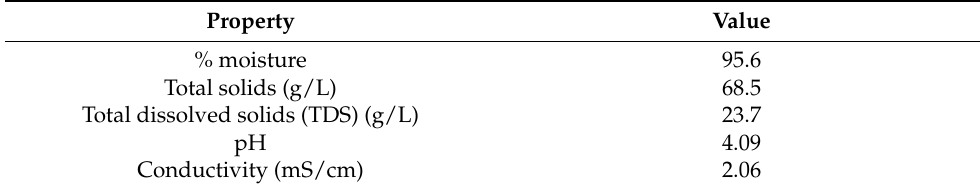
Table 1. Basic physicochemical properties of collected wine lees 1